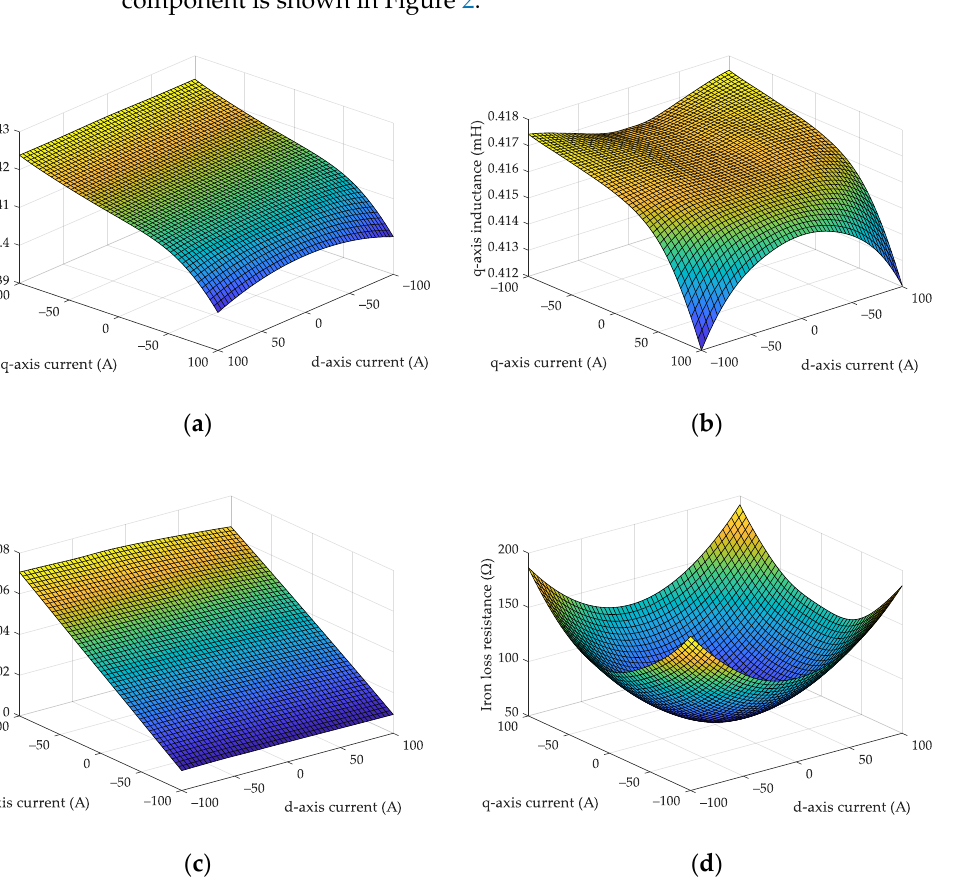
The nonlinear relationship of motor parameters with respect to the d-q axis current component is shown in Figure 2.